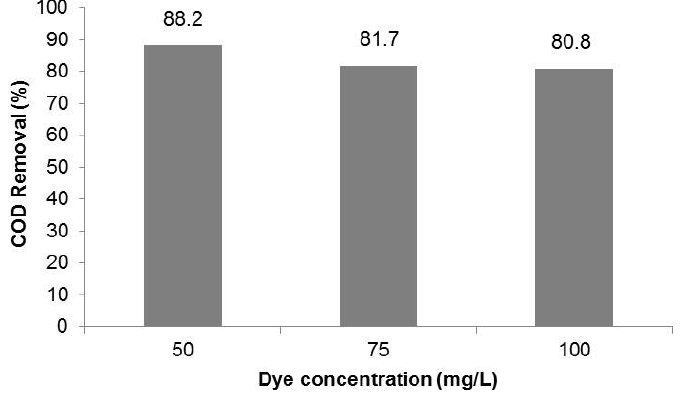
Figure 7. Influence of the dye concentration on COD removal (1 g·L − 1 TiO 2